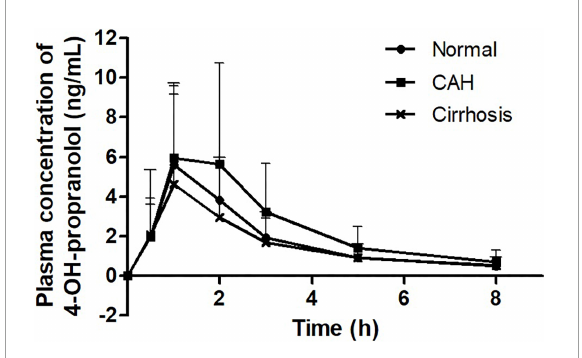
FIGURE2 Plasma concentration-time profiles of 4-OH-propranolol.